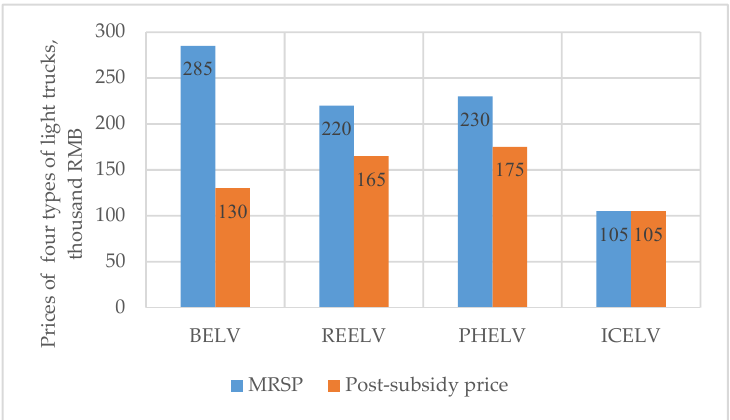
Figure 4. Price comparison of four light trucks in 2017.